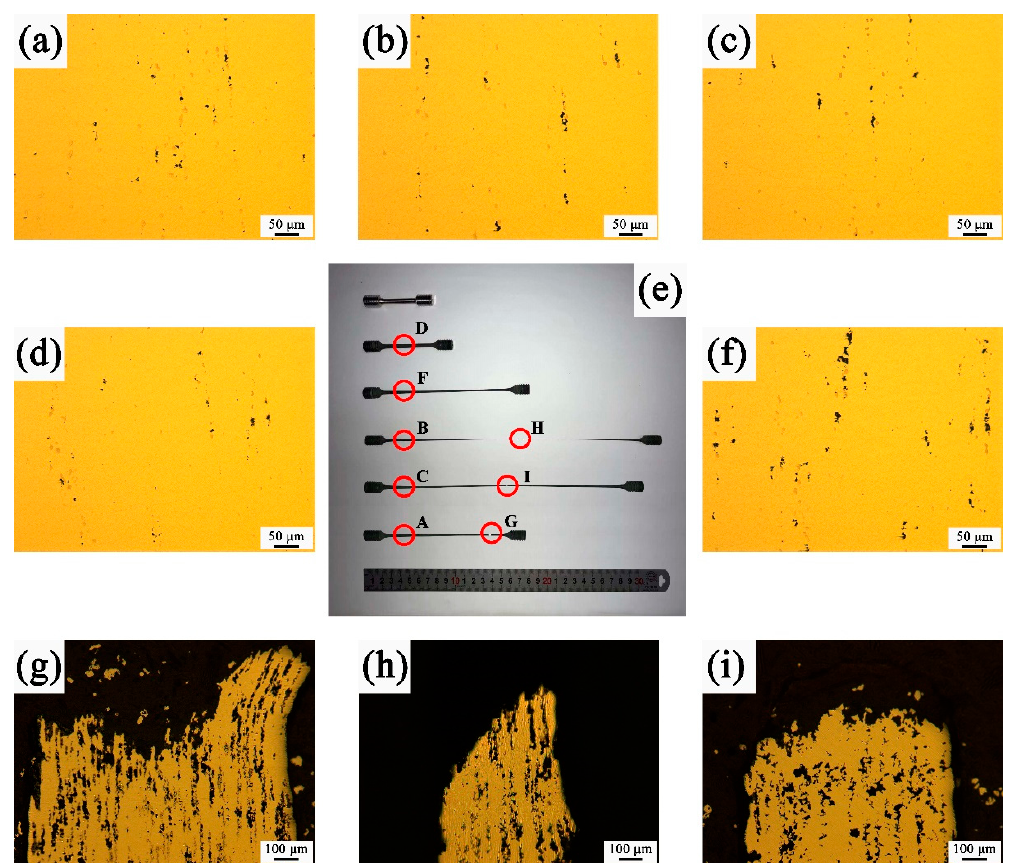
Figure 7. Variation in the amount of cavitation and fracture morphologies in the Tensile specimens ( e ) to failure with the strain rate of 1 × 10 − 3 s − 1 at 1060 °C ( a , g ); 1080 °C ( b , h ); 1100 °C ( c , i ) and interrupted at 1080 °C with strain rate of 1 × 10 − 3 s − 1 at different ductility, respectively: ( d ) 61.8% and ( f ) 350.5%.